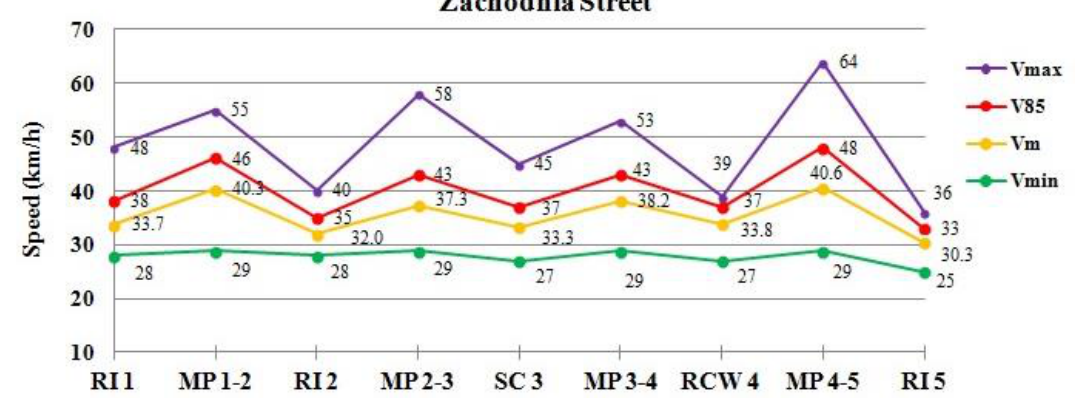
Figure 4. Speed values in the measurement points in Zachodnia Street, in Bialystok (Poland).